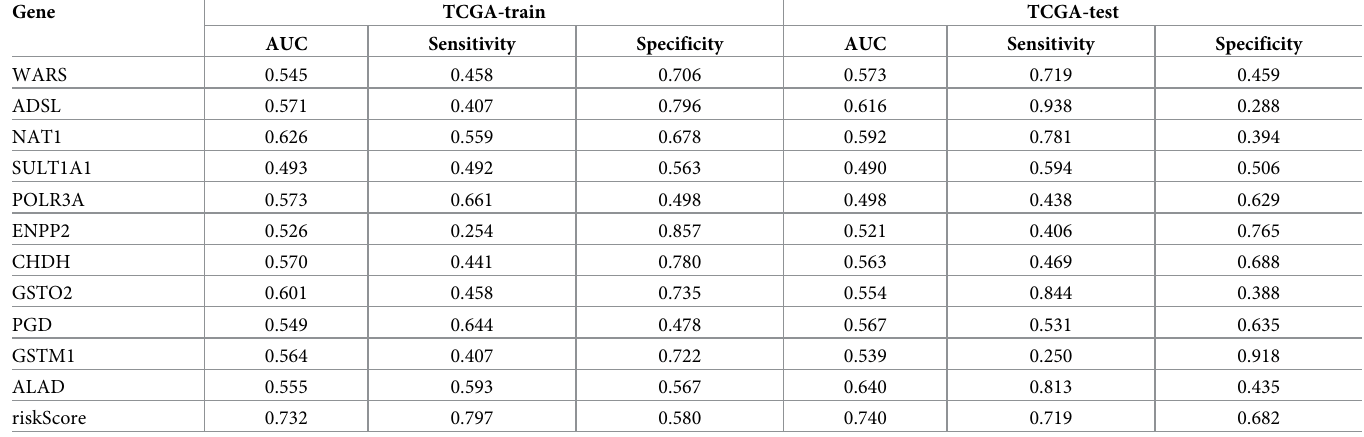
In order to further analyze if the prognostic model can be used as an independent risk factor for evaluating the prognosis of CRC, we conducted univariate and multivariate COX analysis of the prognostic model and clinicopathological characteristics [24]. Univariate (Fig 3G) and multivariate (Fig 3H) Cox regression analysis of 392 subjects in the TCGA-CRC cohort Table 3. ROC analysis of train and test